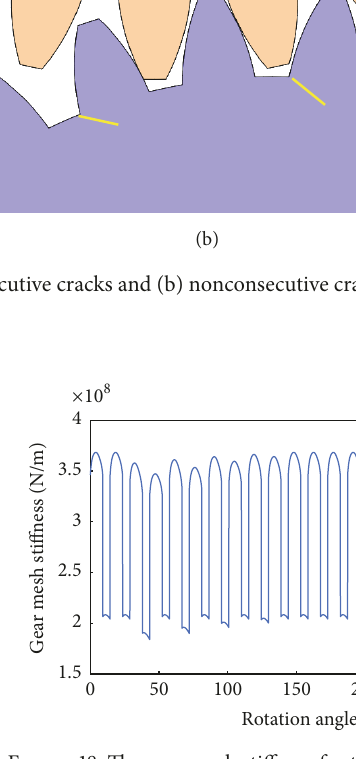
Figure 16: The gear mesh stiffness for the first scenario (two non- consecutive cracked teeth with 30% CLP).